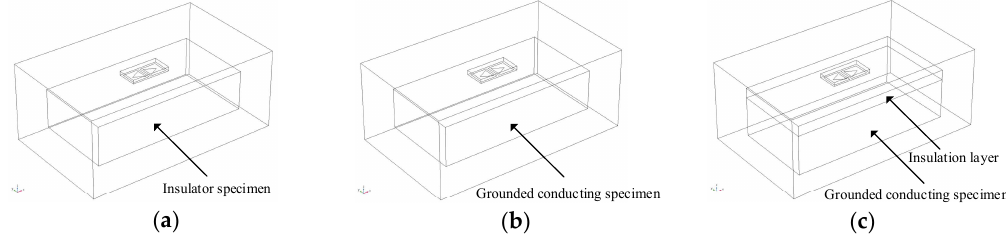
Figure 5. Model geometries for ( a ) Model 1, ( b ) Model 2 and ( c ) Model 3.